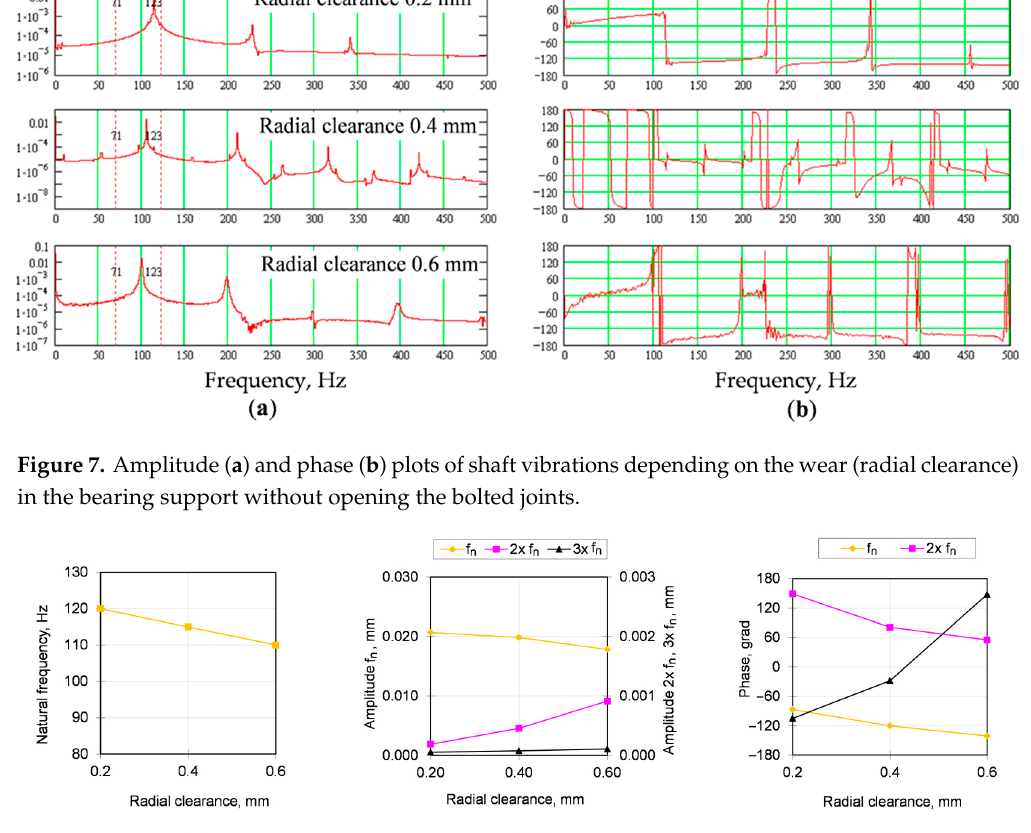
Figure 7. Amplitude ( a ) and phase ( b ) plots of shaft vibrations depending on the wear (radial clearance) in the bearing support without opening the bolted joints. Table 2. Results of vibration measurements (Figure 8).